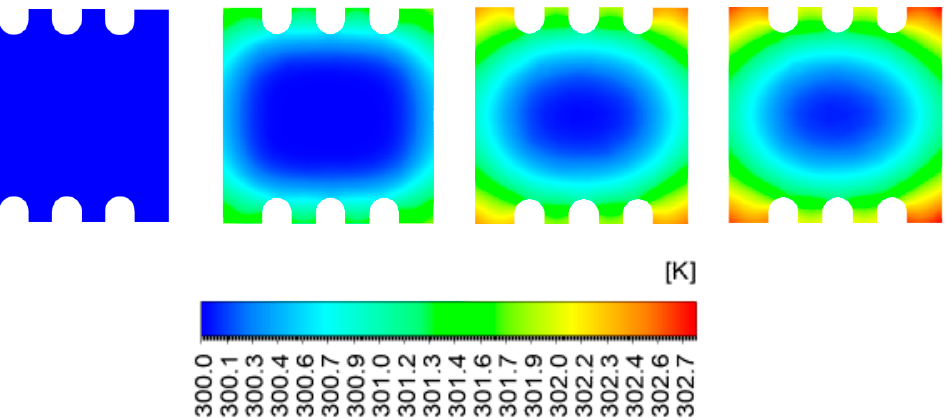
Figure 9. Temperature distribution at Re = 1000 and volume fraction 0.01%.